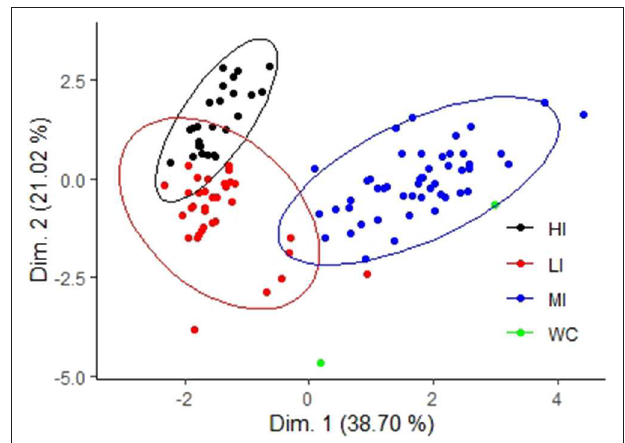
FIGURE 1 | Hierarchical clustering of identified clusters LI, MI, HI, and WC, referring to low intensified farms, moderately intensified farms, highly intensified farms and wrongly classified farms, respectively.